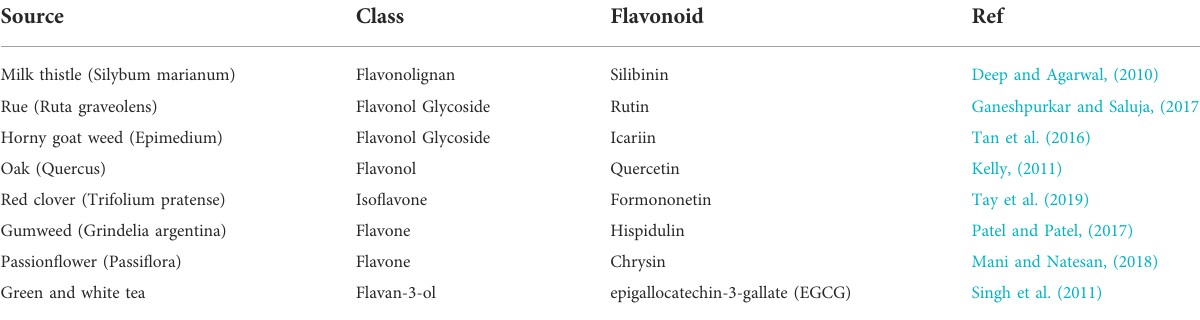
TABLE 2 Major classes of fl avonoids interacting with chemotherapeutic agents to inhibit